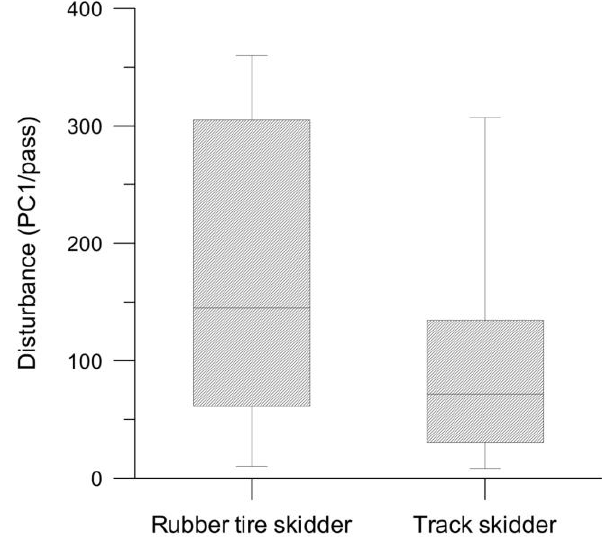
Figure 3. Red Eagle Fire: disturbance comparison between the rubber tire and track skidders. The boxes represent the upper and lower quartiles and the midline represents the median. The minimum and maximum data values are shown by the caps on the whiskers.